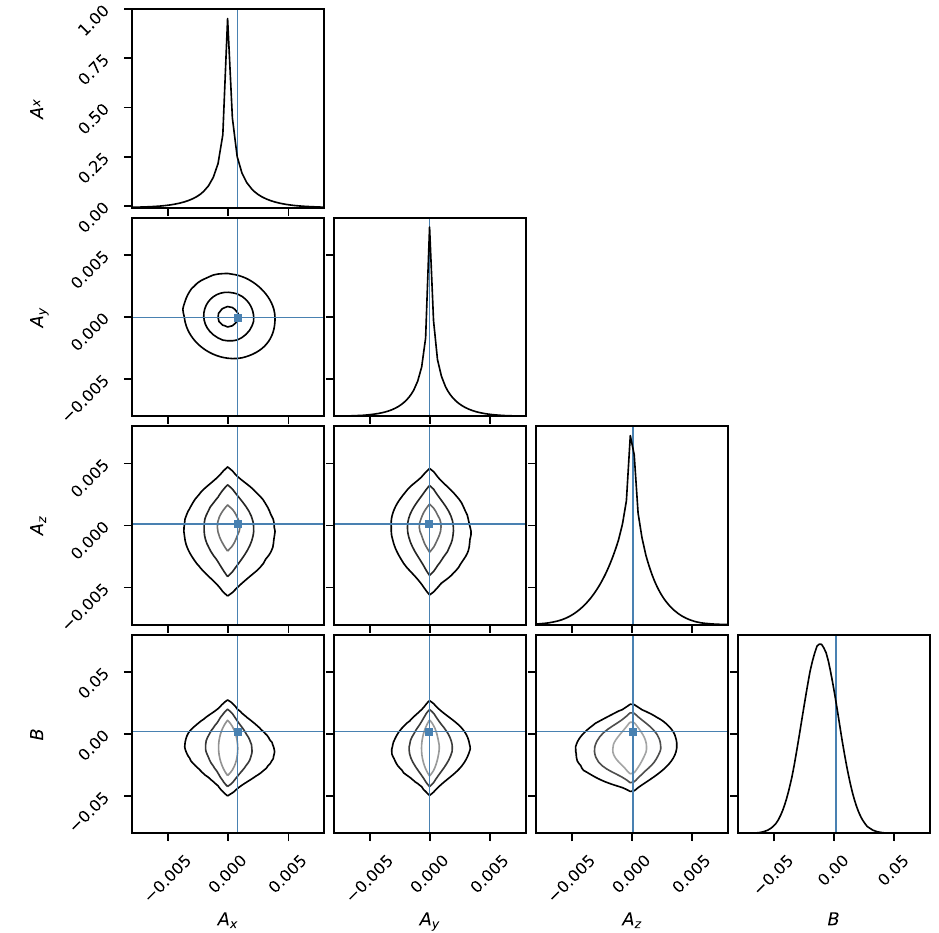
Fig. 9 Probability distribution functions of rectangular components of dipole A and monopole B for JLA data set directly using ( l , b , A ) as fitted